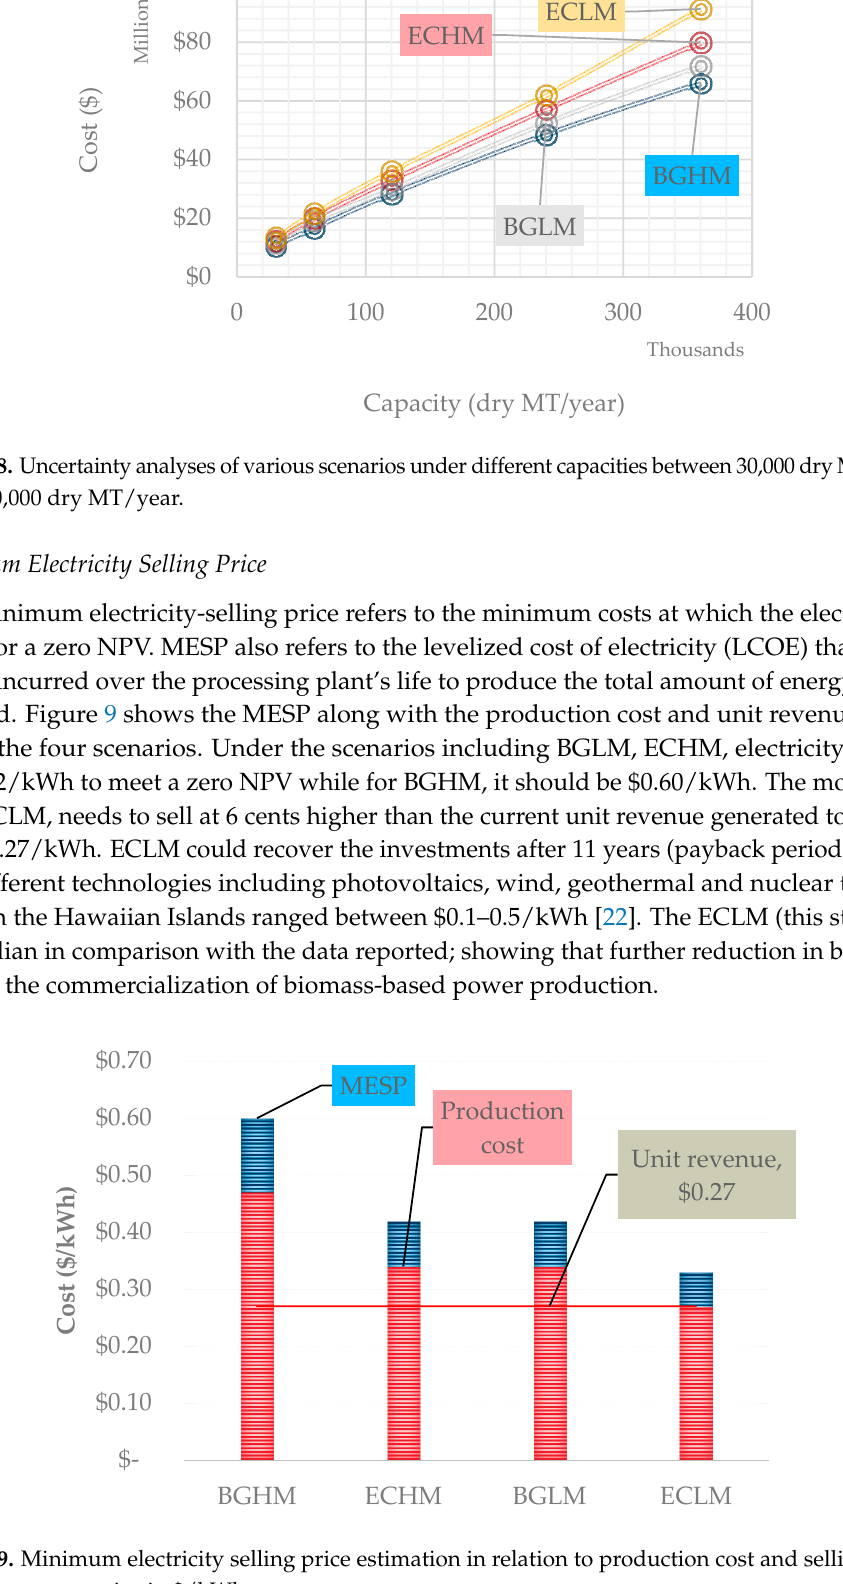
Figure 9. Minimum electricity selling price estimation in relation to production cost and selling price for different scenarios in $/kWh.